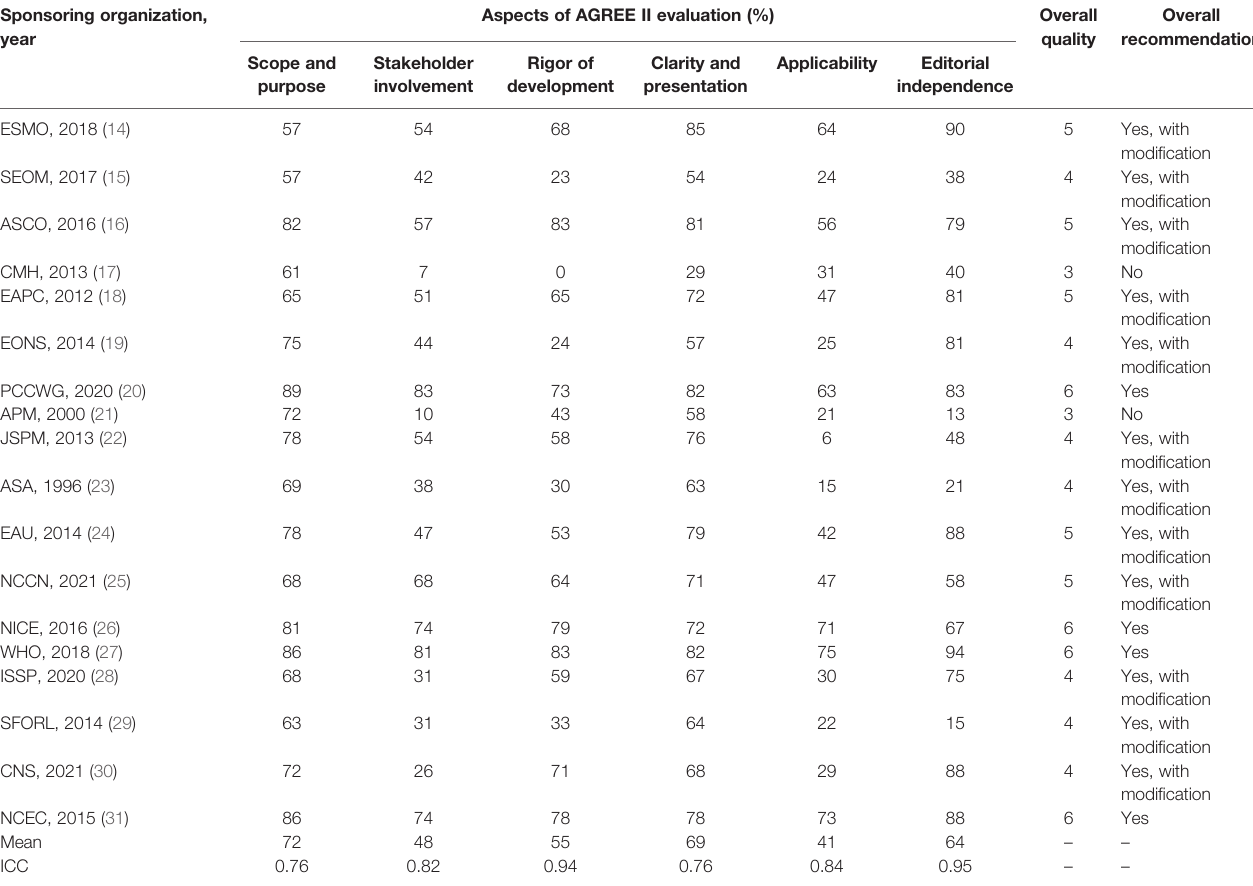
TABLE 2 | Appraisal of Guidelines for Research and Evaluation (AGREE) II scores of cancer pain CPGs.